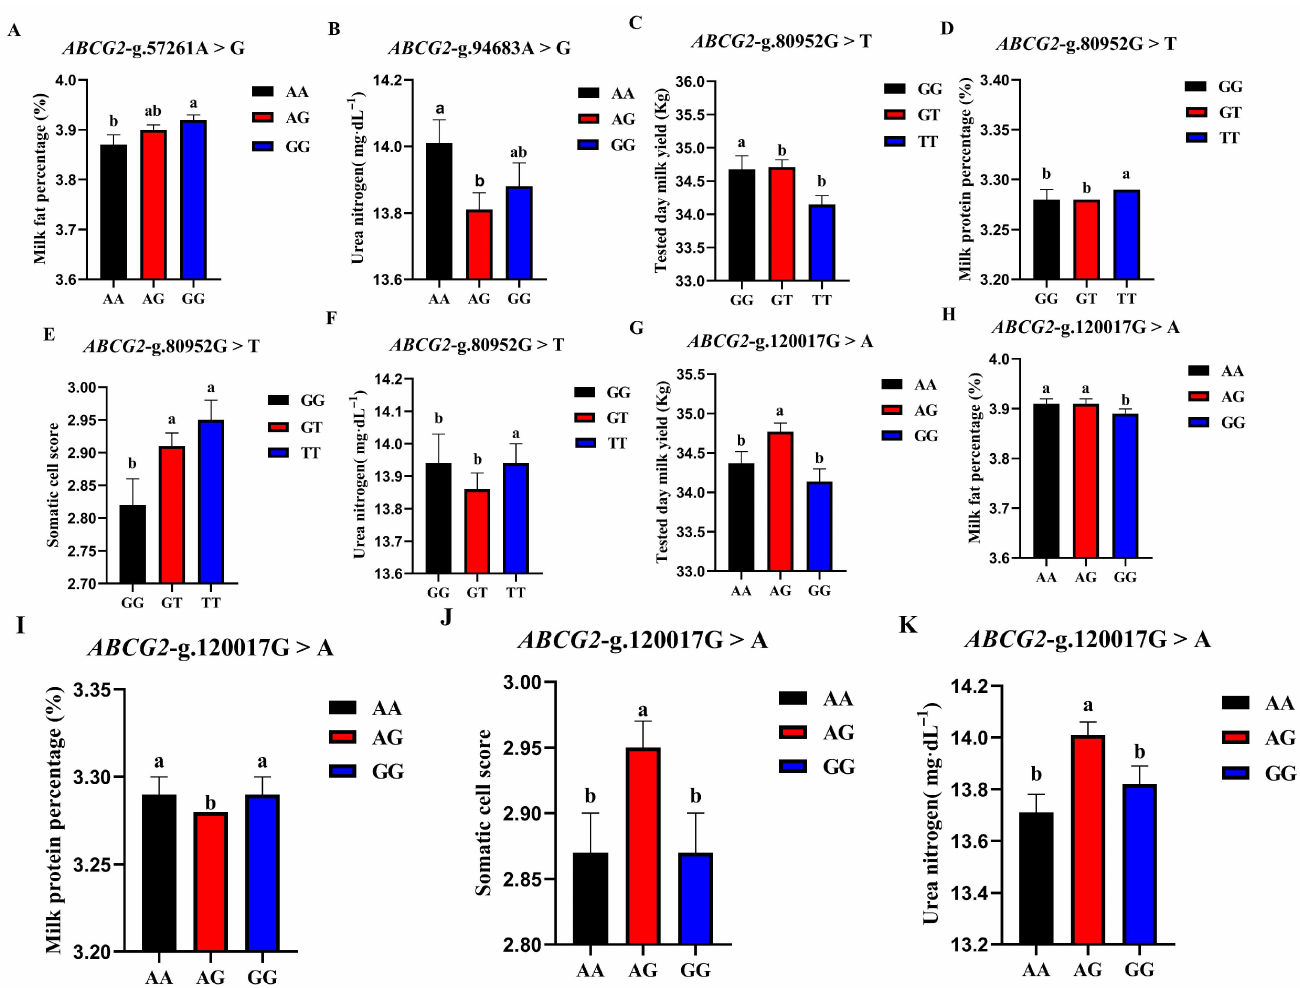
Figure 6. Effect of different genotypes in ABCG2 four SNP loci on production traits in Chinese Holstein cattle. ( A ) The milk fat percentage of GG-type cows in the ABCG2 -g.57261A > G locus was significantly higher than that of AA-type and AG-type cows. ( B ) ABCG2 -g.94683A > G locus had significantly higher urea nitrogen content in the milk of AA type cows than AG and GG types. In ABCG2 -g.80952G > T locus, the tested day milk yield ( C ) of TT type cows was significantly lower than that of GG and GT type cows; somatic cell score ( D ), milk protein percentage ( E ), and urea nitrogen ( F ) of TT type cows were significantly higher than GG and GT types. In ABCG2 -g.120017G > A locus, AA type cows tested day milk yield ( G ) was significantly higher than that of AG and GG type cows, and the milk protein percentage ( H ), milk fat percentage ( I ), somatic cell score ( J ) and urea nitrogen ( K ) of AG type cows were significantly higher than those of AA and GG type cows. Data in the same column with different lowercase letters on the shoulder indicate significant differences ( p <